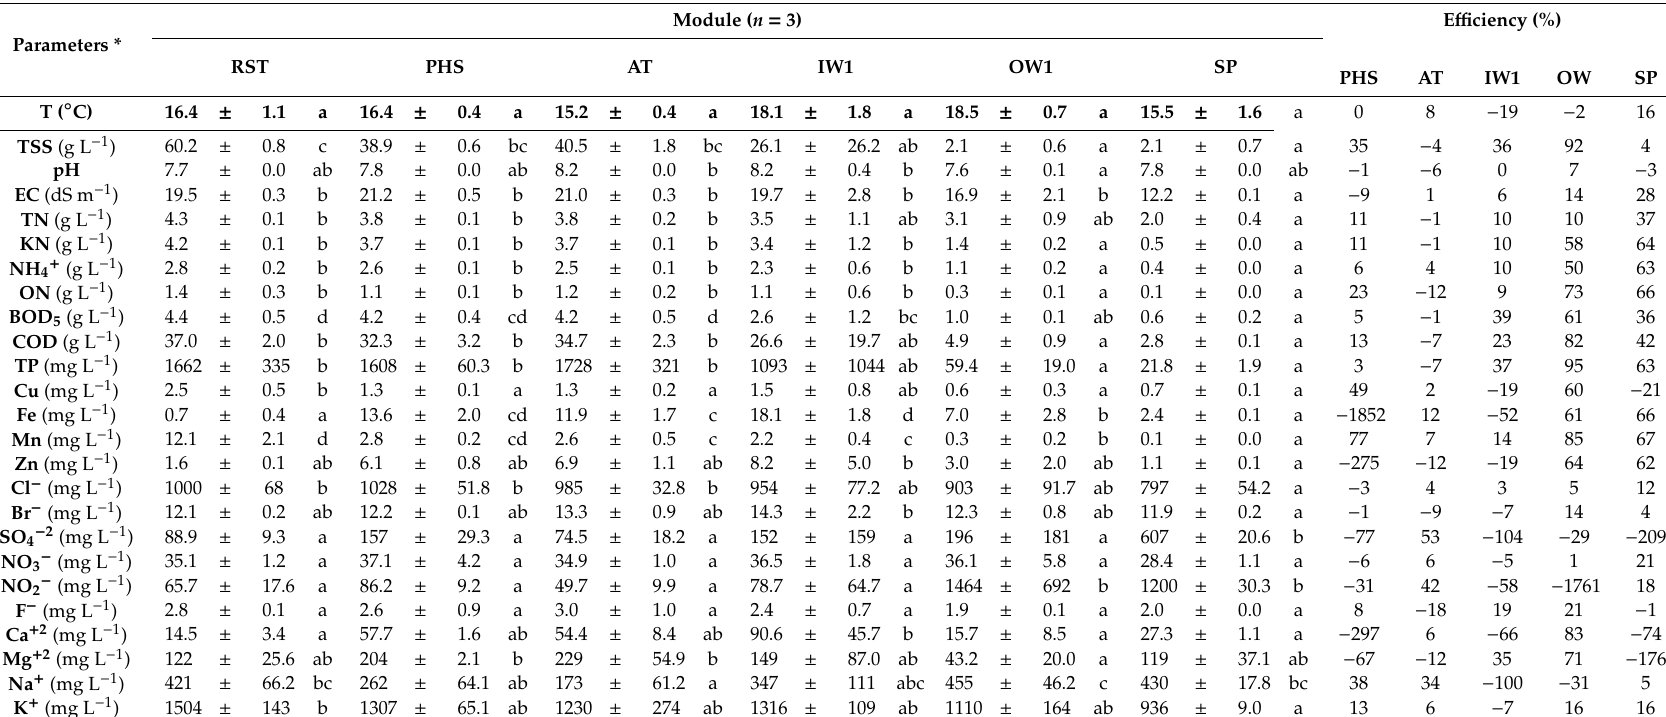
Table 1. Mean and standard deviation values, e ffi ciencies of each module for unplanted cell (W1). E ffi ciency is referred to a previous